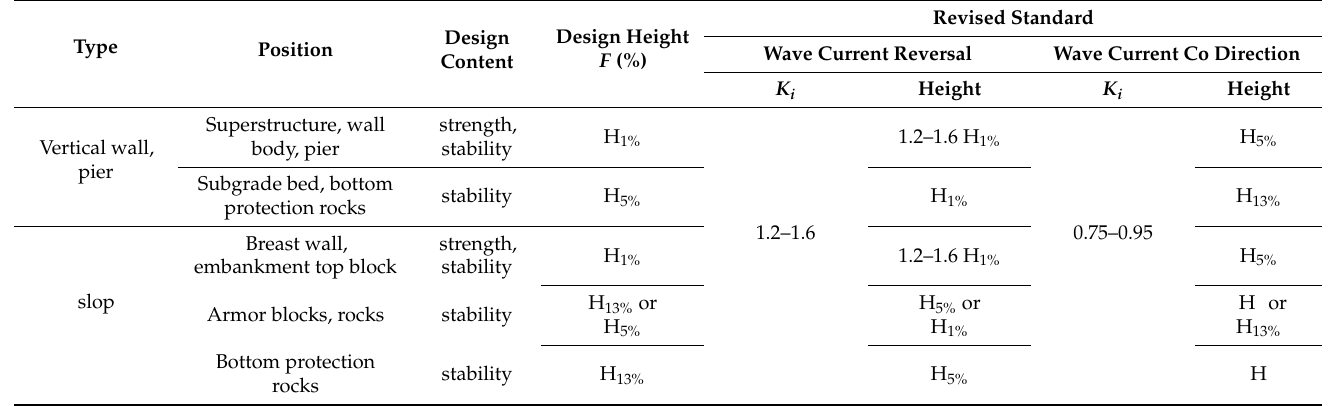
Table 3. Revision of design wave height cumulative frequency standard.